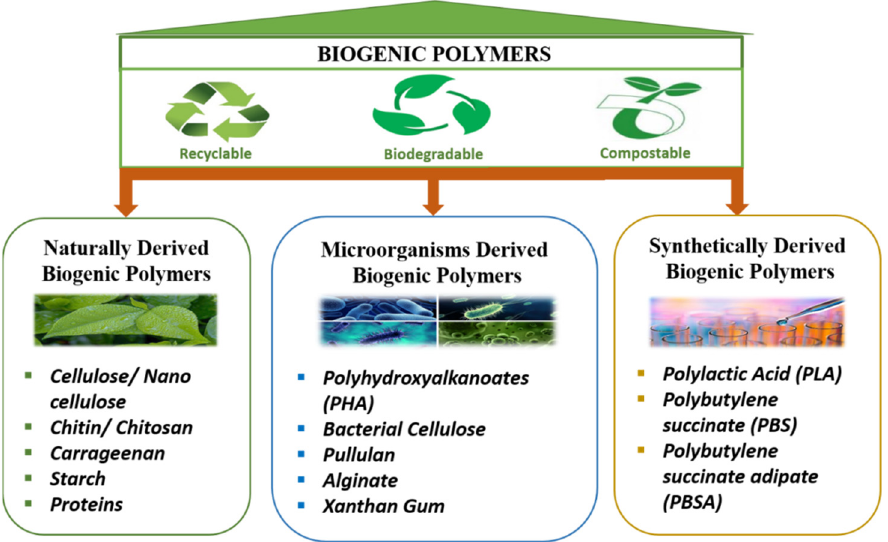
Figure 1. Schematic categorization of biogenic polymers.